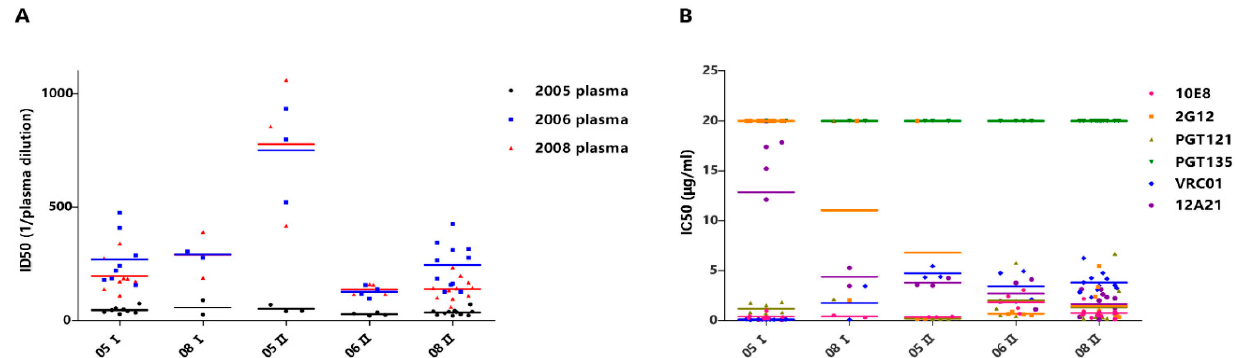
Figure 4. Viruses’ neutralization sensitivity to autologous plasma and bNAbs. ( A ) Comparison of neutralization sensitivity of Cluster I and Cluster II viruses to autologous plasma of three time points (20050816, 20060418, and 20081118). The neutralization sensitivity was measured as ID50 in dilution of the plasma. ID50 < 20 has been set to ID50 = 20. ( B ) Comparison of neutralization sensitivity of Cluster I and Cluster II viruses to several well-known bNAbs. IC50 > 20 µg/mL has been set to IC50 = 20 µg/mL.